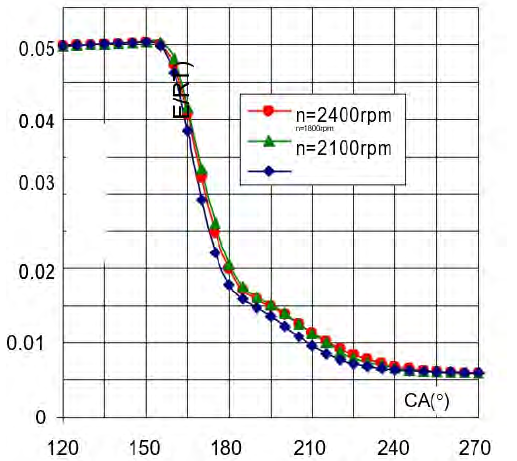
Figure 12. Variation of X f .exp(-E/RT) in function of crank angle with different engine speeds (D20, ϕ =1)